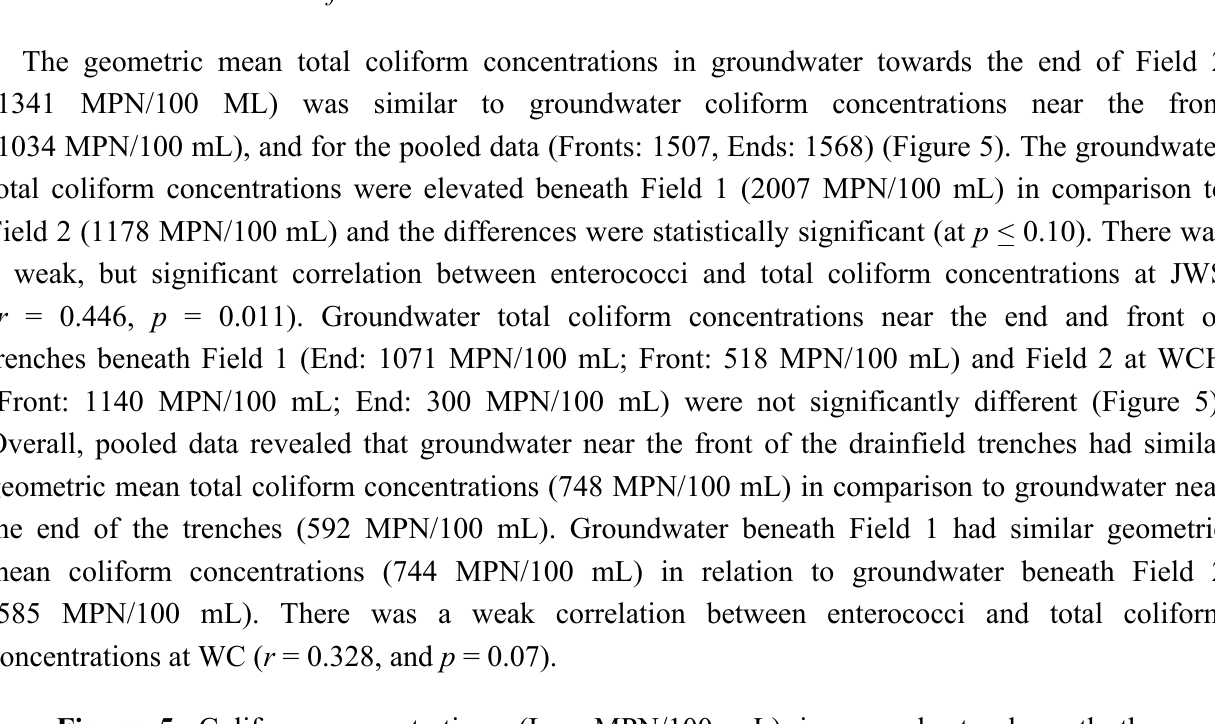
Figure 5. Coliform concentrations (Log MPN/100 mL) in groundwater beneath the drainfields at James W. Smith ( a ) and West Craven High ( b ). Field 1 is F1, Field 2 is F2, front of the field is F, end of the field is E. Data indicate that groundwater coliform concentrations were evenly distributed beneath the systems at both